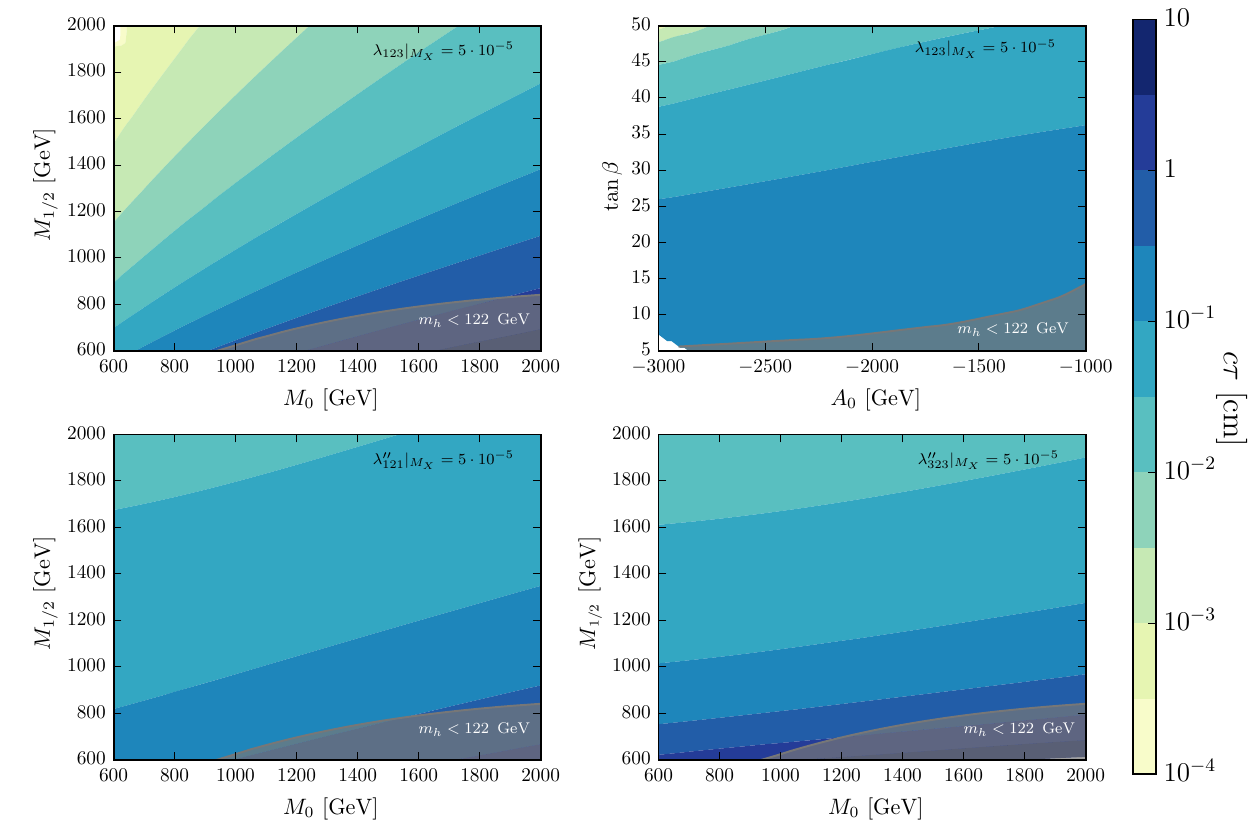
= 5 · 10 − 5 is excluded due to a too small Higgs mass. In the upper-left corner p → τ ˜ τ of the figure, ˜ τ is the LSP, so that the two-body decay ˜ χ 0 1 1 is possible, therefore drastically increasing the neutralino width. For = λ (cid:4)(cid:4) = − λ (cid:4)(cid:4) the lower figures, we have used (cid:6) (cid:5) R (left) and 112 121 p (cid:6) (cid:5) = λ (cid:4)(cid:4) = − λ (cid:4)(cid:4) R p 323 332